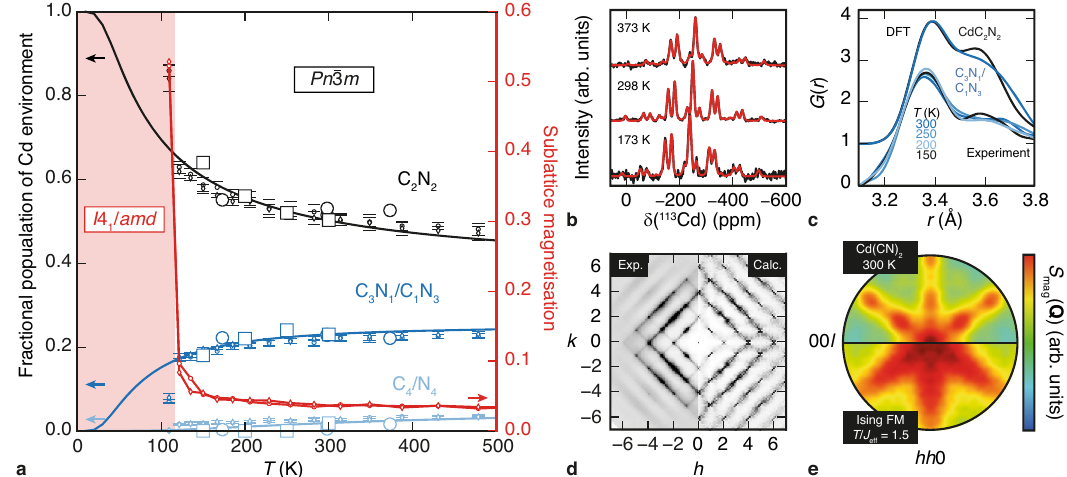
Fig. 4 Calculated and observed structural spin-ice behaviour in Cd(CN) 2 . a Temperature-dependent population of CdC n N 4 – n coordination environments as determined by our MC pseudospin simulations (small symbols; error bars denote the standard error measured from fi ve independent MC simulations), neutron PDF measurements (open squares) and 113 Cd MAS NMR spectroscopic measurements (open circles), compared with the non-interacting analytical result (solid lines, ref. 34 ). The sublattice magnetisation (red symbols, red line) — or polarisation, in the speci fi c context of Cd(CN) 2 — is an order parameter for the transition between the disordered ( Pn (cid:1) 3 m ) spin-ice state and the low-temperature ( I 4 1 = amd ) antiferroelectric state. b Variable- temperature 113 Cd MAS NMR spectra (black lines) and corresponding fi ts (red lines) used to extract the values given in a . c Variable-temperature neutron PDF data (lower curves) and calculated PDFs from γ ¼ 0 and 2 QC con fi gurations (upper curves) used to determine the PDF-derived values in a . d Single- 3 crystal X-ray diffuse scattering pattern (( hk 0) plane) measured at 298 K and calculated from a coupled CN-orientation/Cd-displacement model based on the 298 K pseudospin con fi guration. e Effective magnetic diffuse scattering pattern (( hhl ) plane) extracted from our 300 K MC simulations by interpreting CN – orientations from a single pyrochlore sublattice as classical spin vectors with the Dy 3 + magnetic form factor (top panel). Calculated magnetic scattering for the pyrochlore Ising ferromagnet for the same relative temperature T = J eff = 1.5 to which the Cd(CN) 2 data correspond (bottom panel). In both cases, fl uctuations away from the spin-ice ground state broaden the pinch-point features observed in experimental magnetic diffuse scattering pattern measured, for e.g., spin-ice Dy 2 Ti 2 O 7 at 1.3 K 68 . Instead the scattering feature resemble more strongly the inelastic magnetic neutron scattering for strongly fl uctuating spin-ice system such as Pr 50 2 Zr 2 O 7